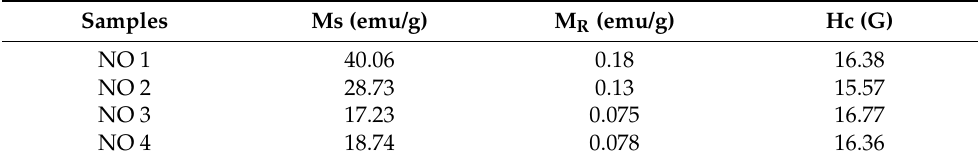
Table 7. Magnetic properties of MREs for different ratios of